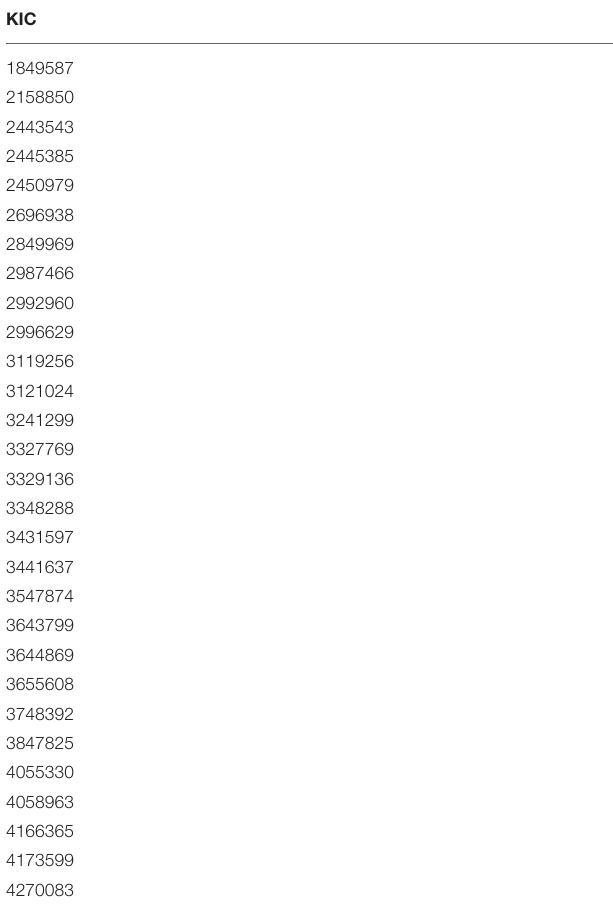
TABLE 2 | KIC numbers of the non-oscillating stars without measured rotation periods (The full table is available in the Supplementary Material ).